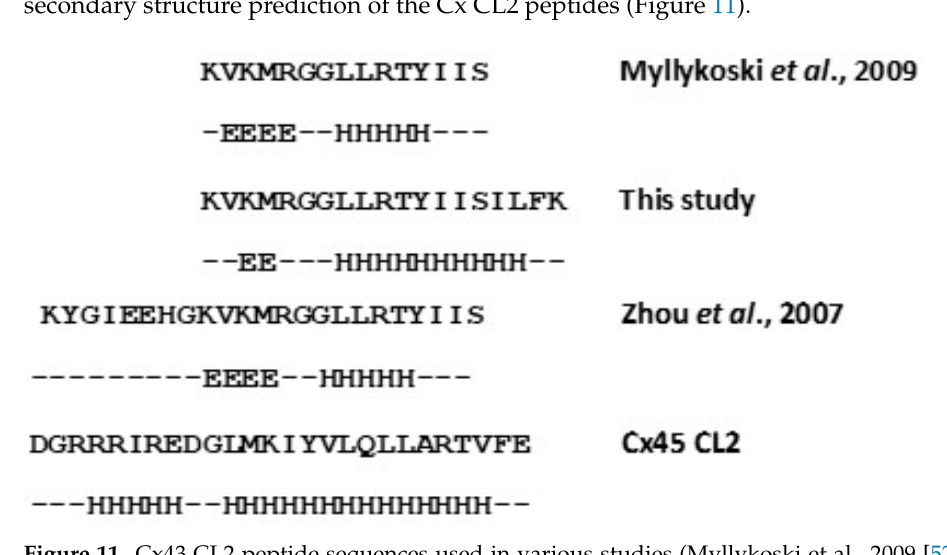
Figure 11. Cx43 CL2 peptide sequences used in various studies (Myllykoski et al., 2009 [52] and Zhou et al., 2007 [53]). Secondary structure prediction was performed using JPred [54]; E: extended; H: Helical). A similar break in the helical prediction exists for all our Cx CL2 peptides (see Cx45 CL2 peptide as an example).